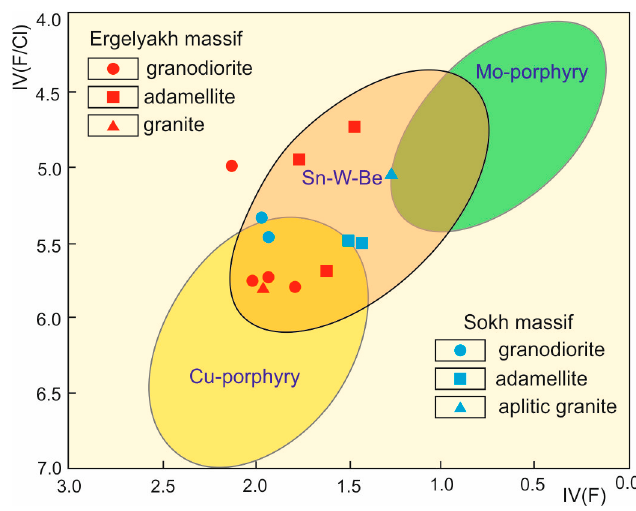
Figure 13. Discrimination diagram of IV(F / Cl)–IV(F) coordinates for biotites from Ergelyakh and Sokh massif granitoids [60].